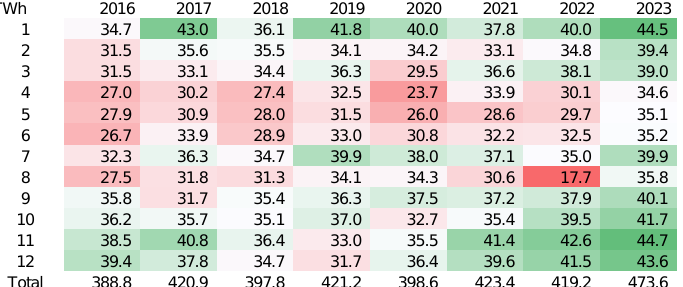
Figure 8. Positive forecast of natural gas supply to Italian end users for 2024. Forecast exercised for the period September 2022 to December 2023. These data can be found here: https://www. ec.eu- ropa.eu/ (accessed on 20 March 2022).